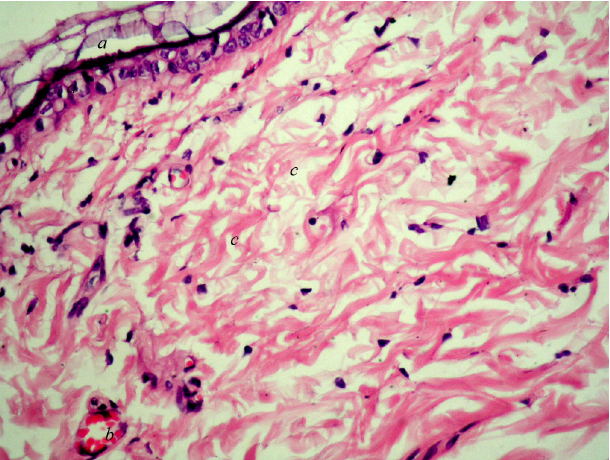
Fig. 1. Histological structure of guinea pig skin on the 7th day of treatment: a – epidermis; b – dilation of blood capillaries; c – derm а . Hematoxylin and eosin. EG. 10, vol. 10